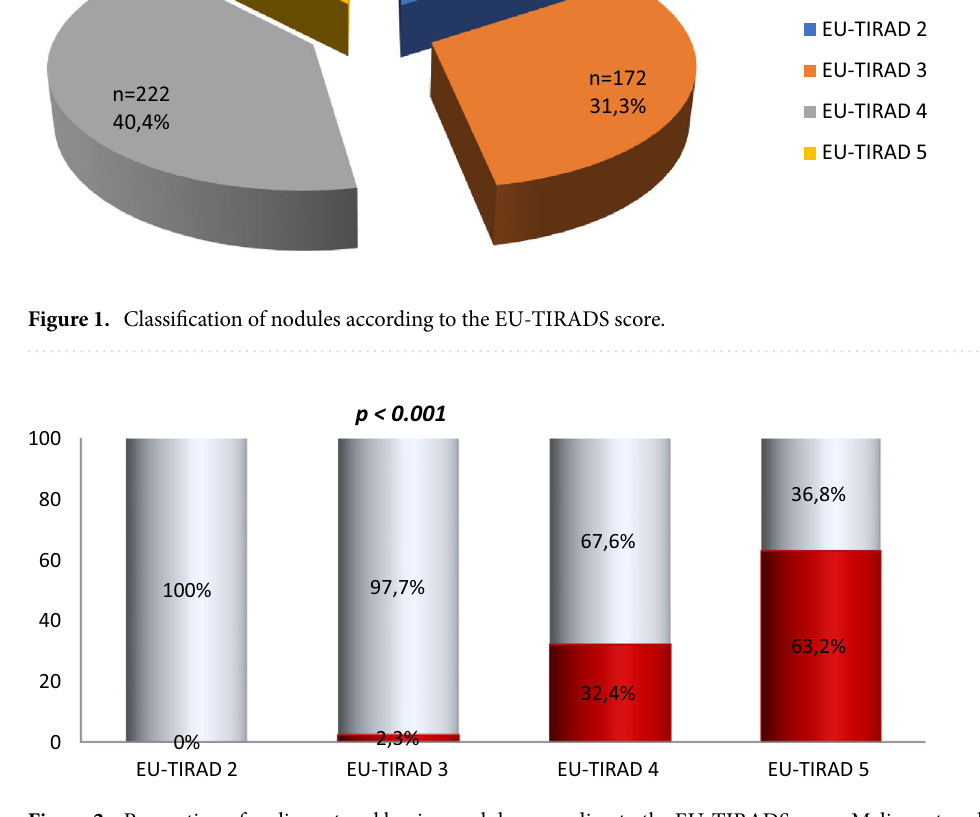
Figure 2. Proportion of malignant and benign nodules according to the EU-TIRADS score. Malignant nodules represented in red and benign nodules represented in